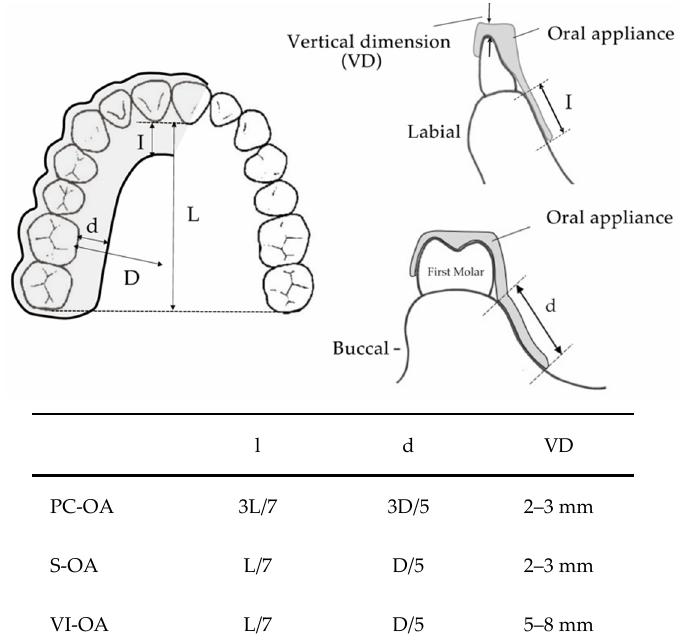
Figure 1. The standard measurements of each OA design.